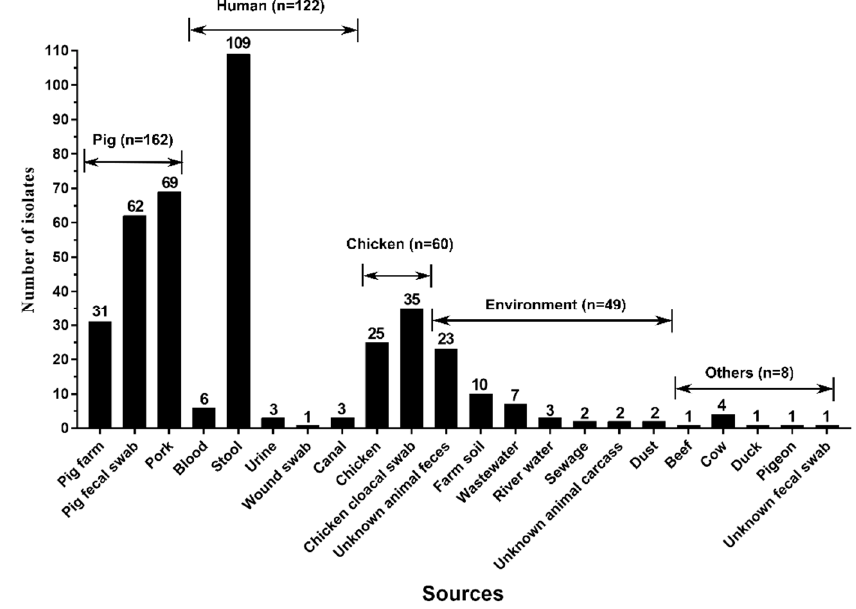
Figure 2. The sample sources of tet (X4)-producing E. coli isolates.